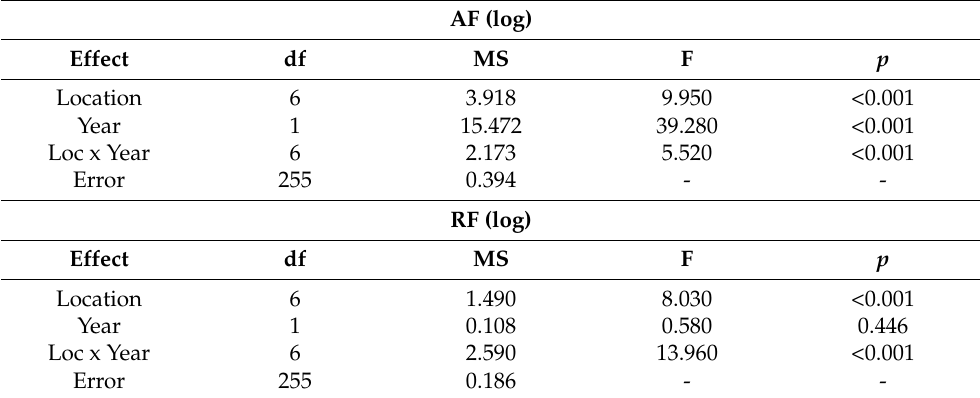
Table 2. Results of Factorial Analysis of Variance (ANOVA) of absolute fecundity (AF, log) and relative fecundity (RF, log) with locations and year as fixed factors (d.f.: estimated degrees of freedom, MS: mean squares).